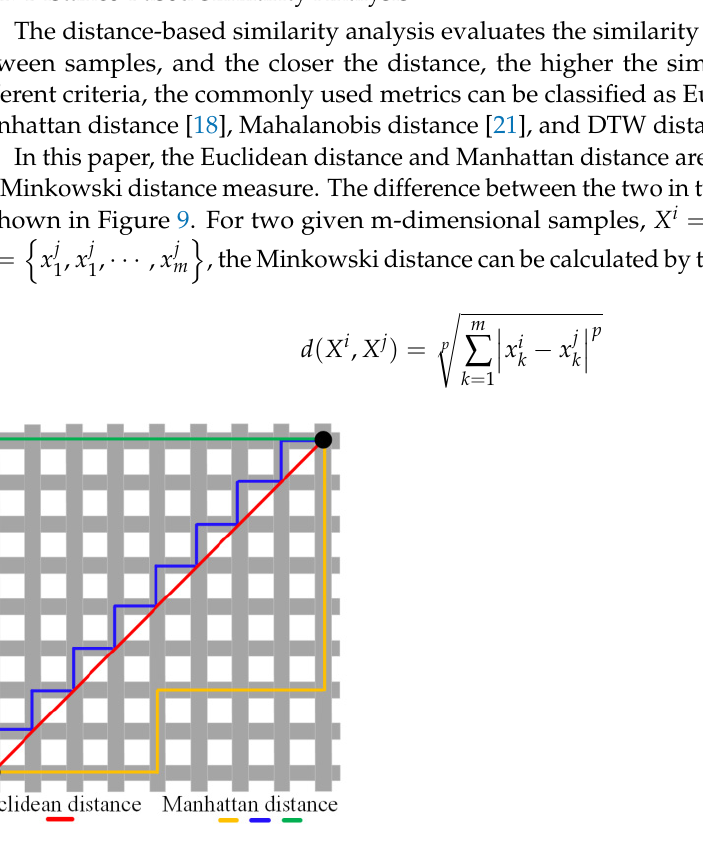
Figure 9. Schematic diagram of Minkowski distance when p is different. When p = 1, Equation (1) is the Manhattan distance. As shown in Figure 8, the Manhattan distance represents the sum of the absolute axis distances of two points on the standard coordinate system, so it is also called the city block distance or cab distance and is widely used as a similarity measure for various samples. When p = 2, Equation (1) is the Euclidean distance. The Euclidean distance is one of the most easily understood distance algorithms representing the straight-line distance between two points in Euclidean space. Euclidean distance is also one of the most commonly used similarity analyses, and many scholars have conducted research based on it. For example, Ref. [19] clusters the historical PV generation data by Euclidean distance to obtain the similarity day matrix and corrects the predicted values, thus improving the prediction